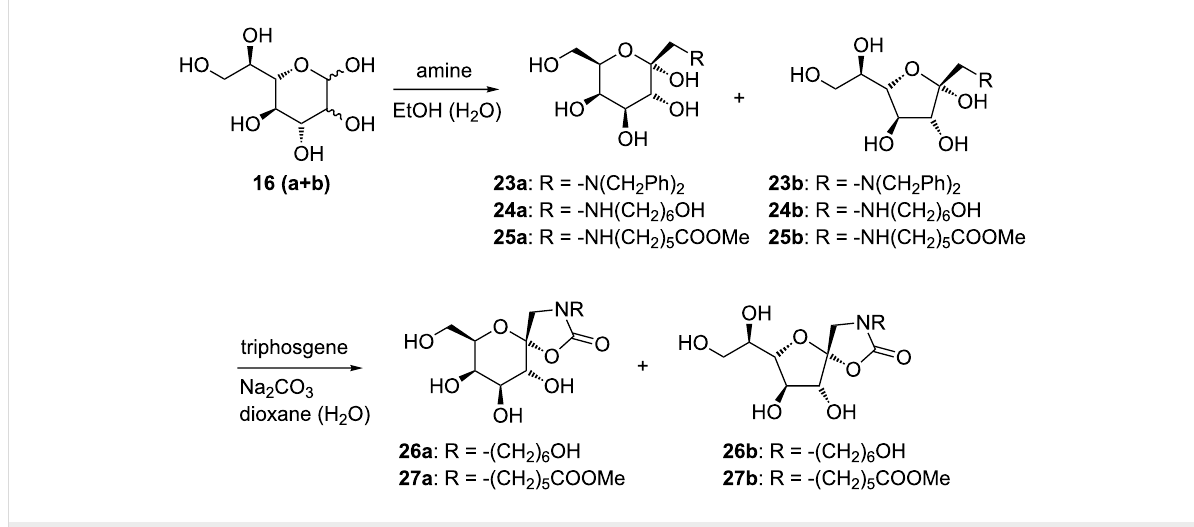
Scheme 5: Amadori rearrangement in the D- galacto series.